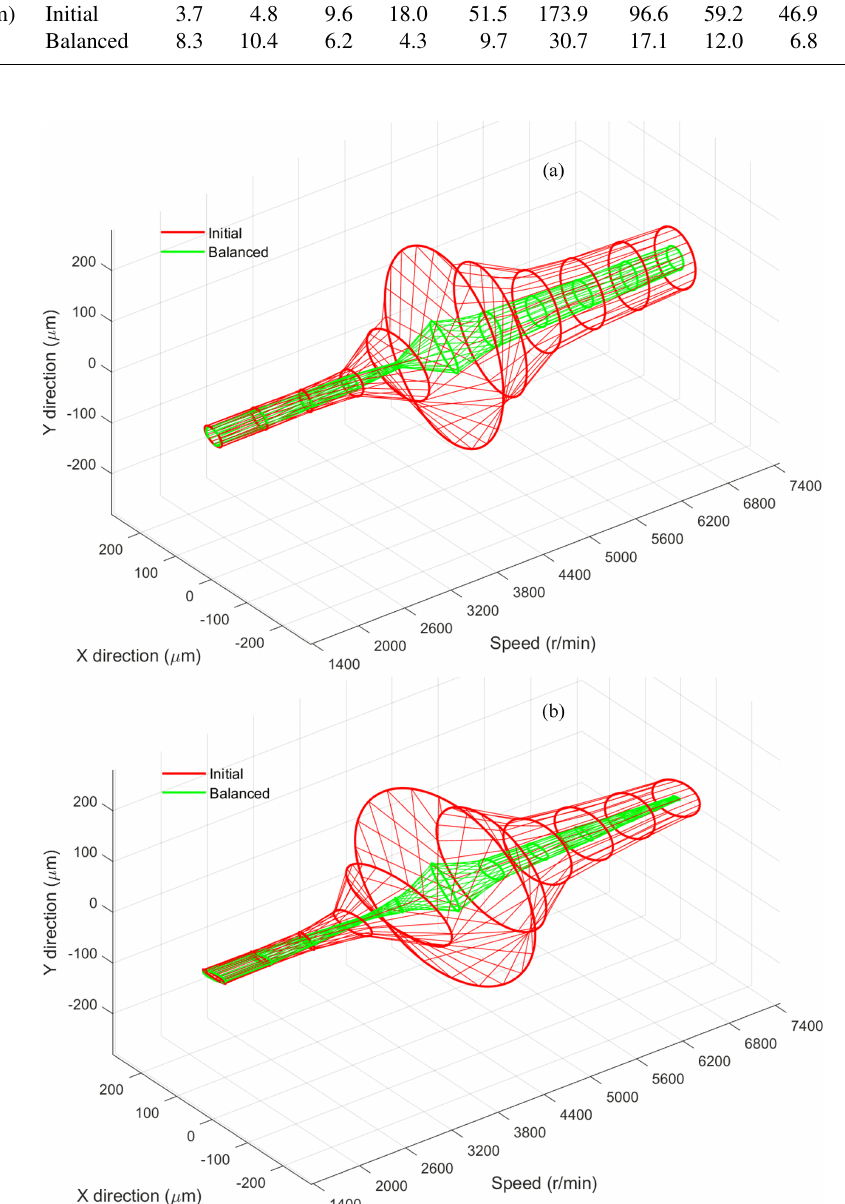
Figure 9. The initial and residual vibration after applying the proposed method. (a) Left-hand side. (b) Right-hand side.